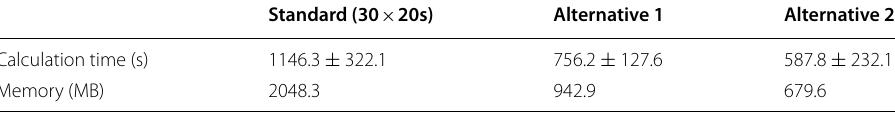
Table 4 Calculation times and memory requirements for the different alternatives in Fig.